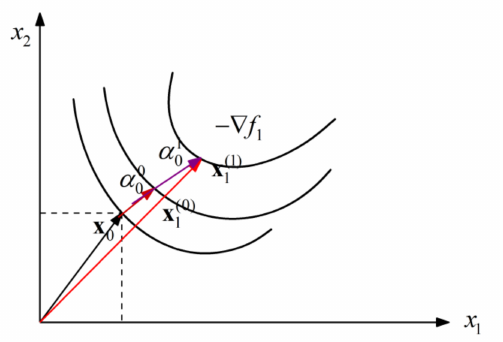
Figure 1. Schematic diagram of one-dimensional search